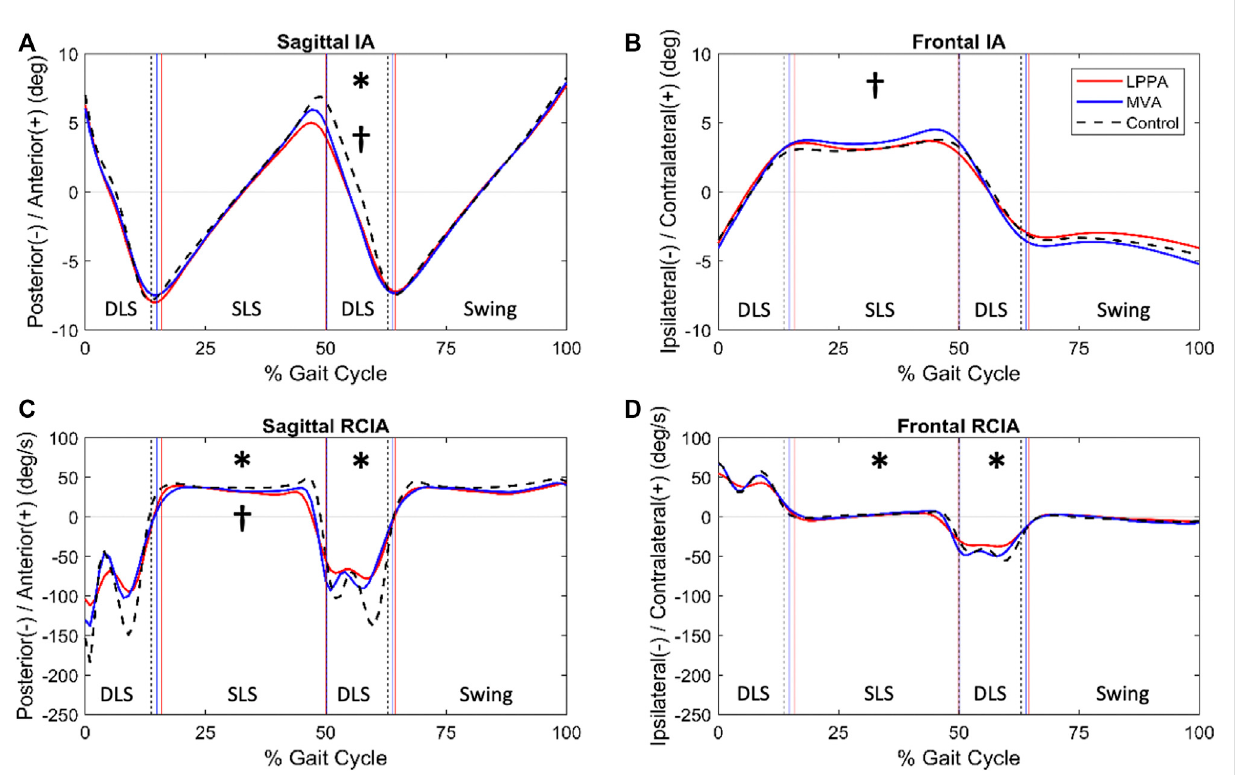
Mean curves of the COM-COP inclination angles (IA) and their rates of change (RCIA) in the sagittal and frontal planes for the knee osteoarthritis groups3 monthsafterTKA via LPPA(redlines)andMVA(bluelines),andthecontrolgroup(blackdashedlines)duringlevelwalkinginthesagittal (A,B) and frontal (C,D) planes.PositivesagittalandfrontalIAindicateCOMpositionsthatareanteriorandcontralateraltotheCOP,respectively.Positivesagittaland frontalRCIAindicateratesofanteriorchangesandcontralateralchangesinthecorrespondingIA,respectively.Heel-strike(HS),contralateraltoe-off (CTO), contralateral heel-strike (CHS) and toe-off (TO) are indicated by vertical lines. IA and RCIA were temporally normalized by the stride time to be in 0% – 100%ofthegaitcycle.Asterisks(*)indicatestatisticalsigni fi cance( p < 0.05)betweenLPPAandControl,andcrosses( † )indicatestatisticalsigni fi cance ( p < 0.05) between MVA and Control for the time-averaged IA or RCIA values over double-limb support (DLS) or single limb-support (SLS)